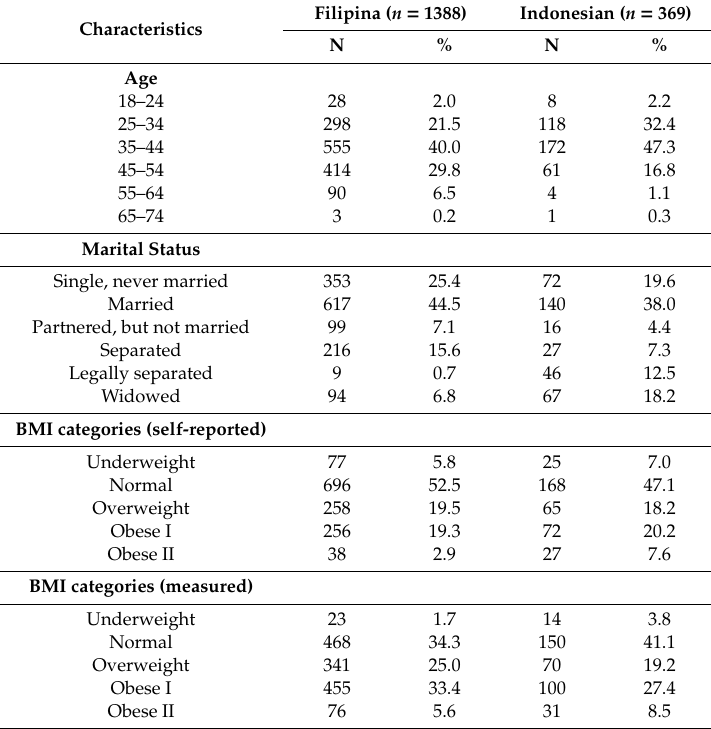
Table 1. Participant